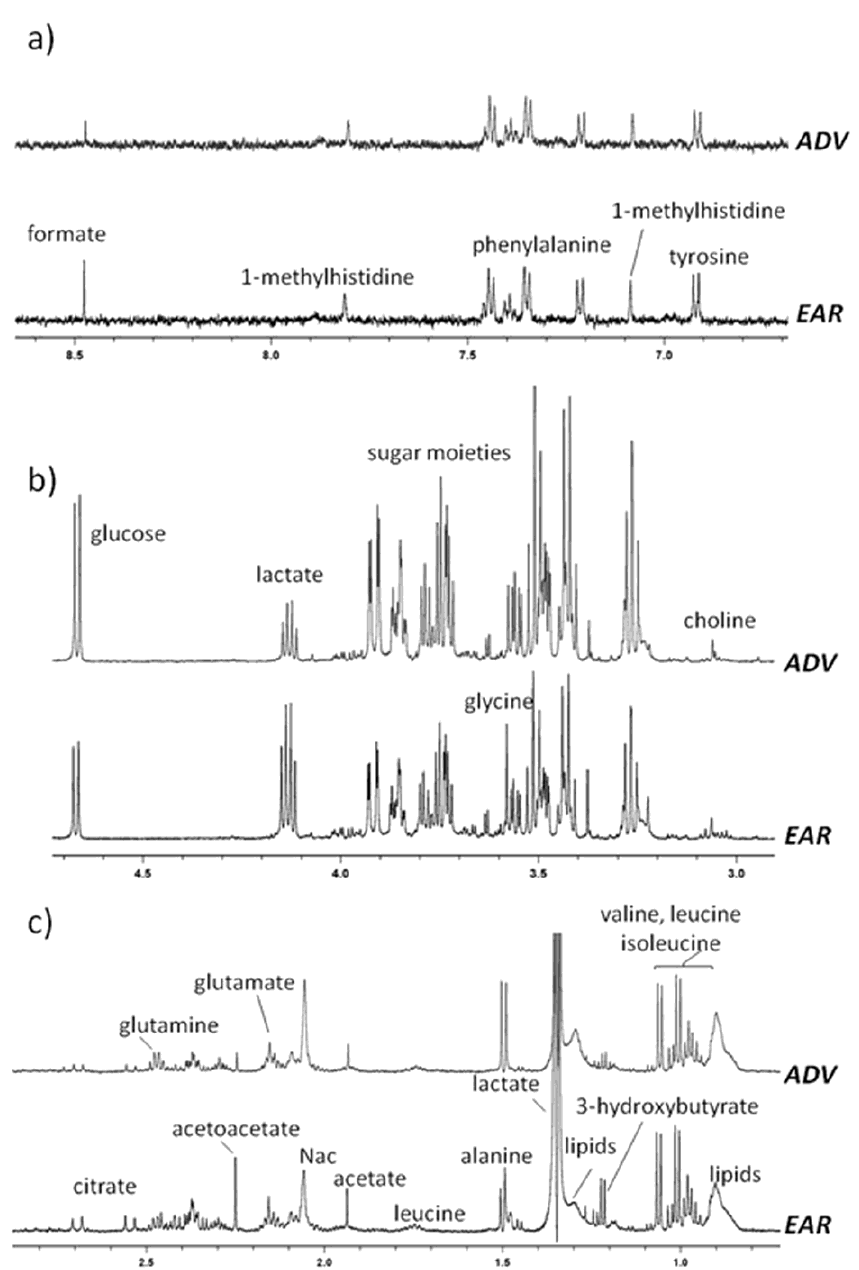
Figure 1. Typical proton Carr–Purcell–Meiboom–Gill nuclear magnetic resonance ( 1 H CPMG NMR) spectra in the ( a ) aromatic, ( b ) sugars and ( c ) aliphatic regions, with some identified metabolites for the different groups of advanced (ADV) and early (EAR) hepatocellular carcinoma (HCC) patients referred to the specific sample spectra in the figure.